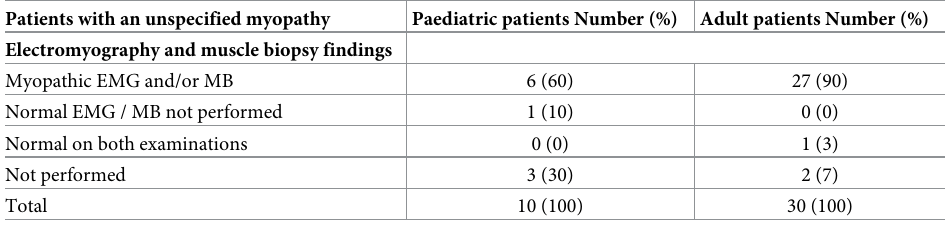
Table 1. EMG and muscle biopsy in paediatric and adult patients with an unspecified myopathy. Patients with an unspecified